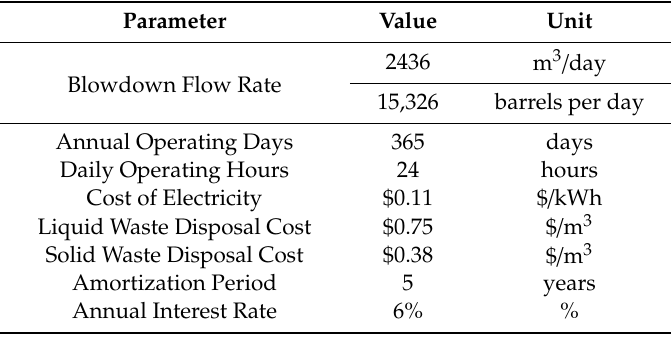
Table 10. Scale up normalized CAPEX and operating cost (OPEX) for each scenario.